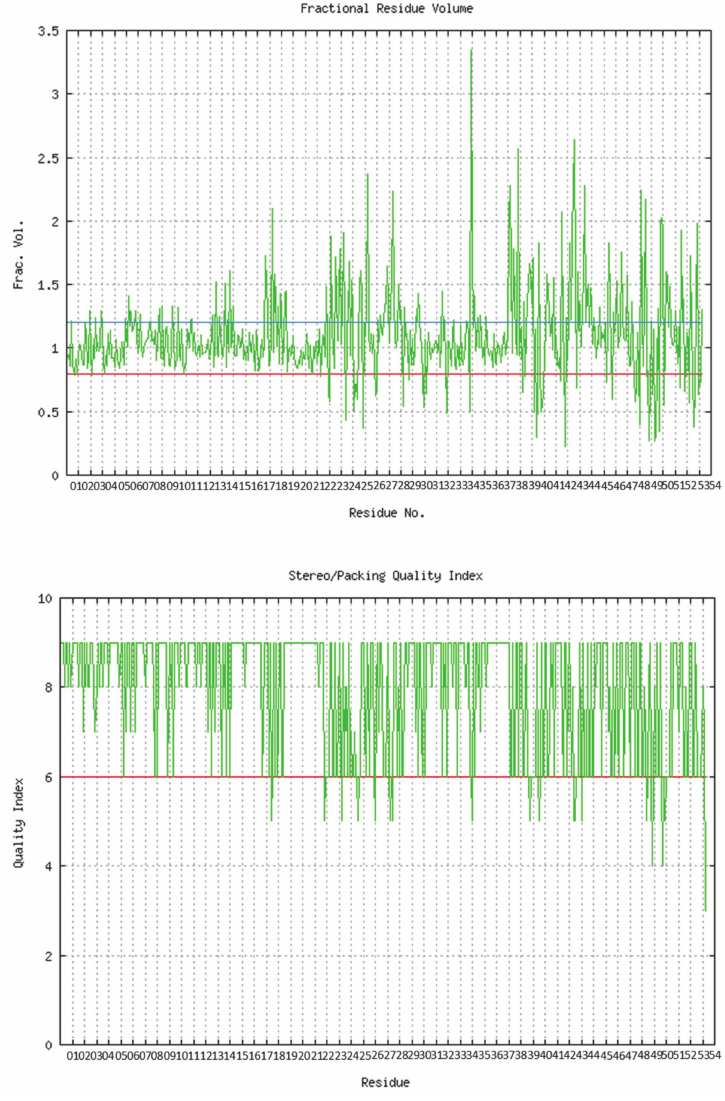
Figure 1. Validation of the predicted 3-D structure of